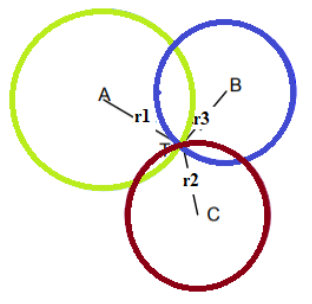
Figure 8. Trilateration.